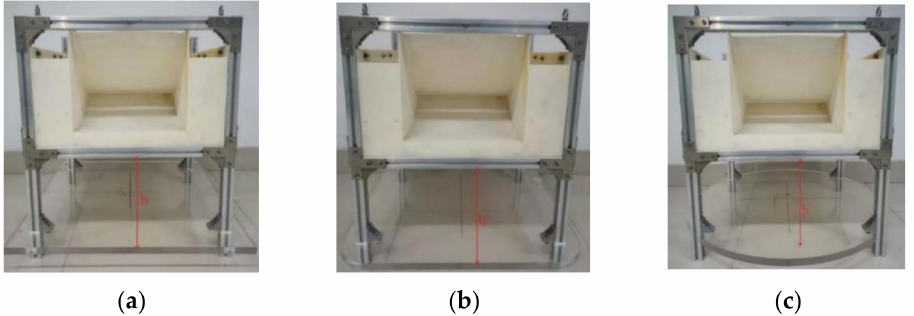
Figure 9. Three different shapes of heaving plate models: ( a ) Scheme 1, ( b ) Scheme 2, ( c ) Scheme